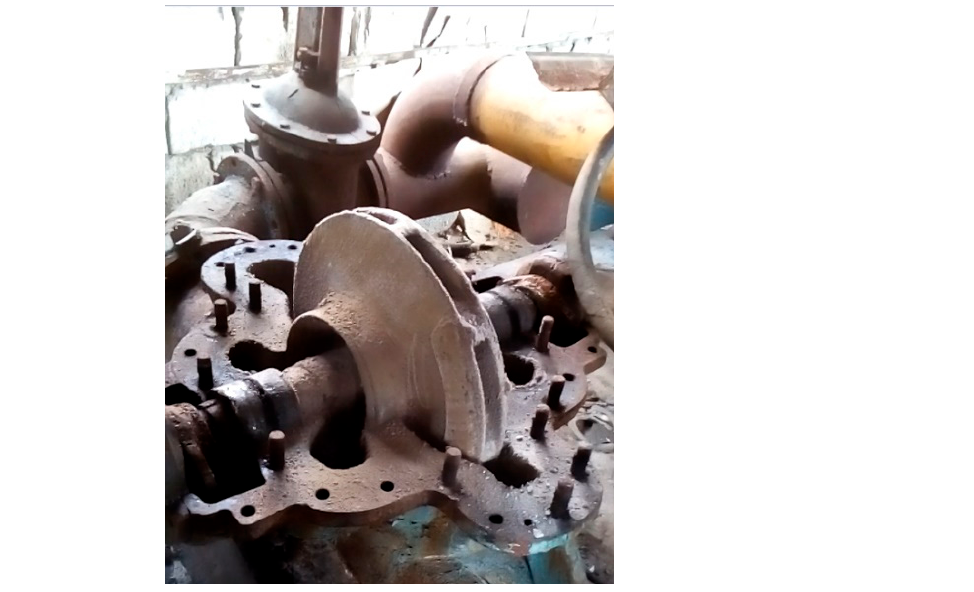
Figure 19. Water pump without shroud after seasonal operation in a geothermal heating system using an acoustic–magnetic device.